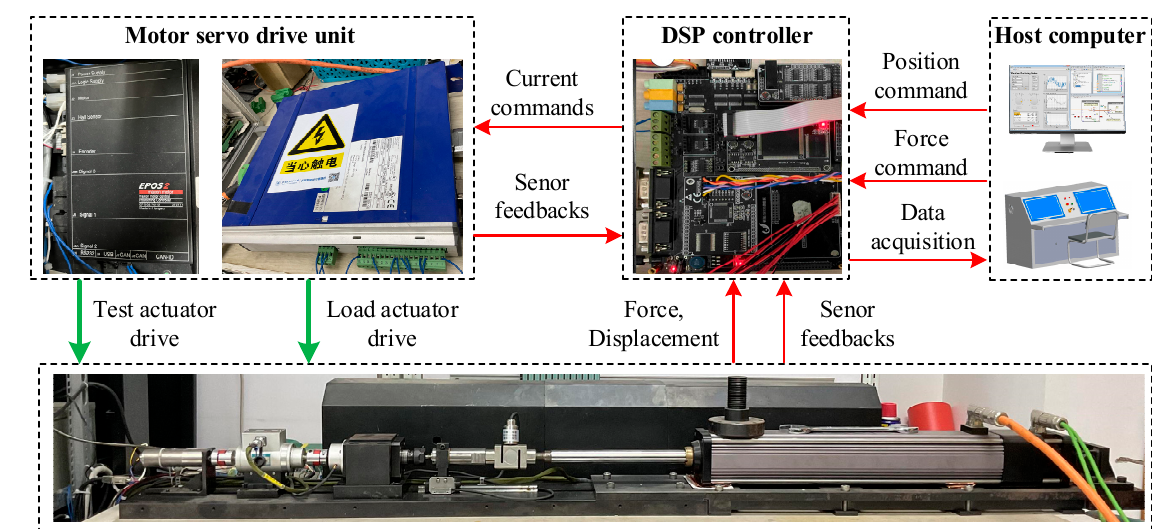
Figure 4. Experimental validation platform for ELLS.